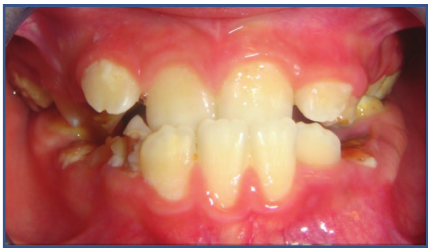
Figure 5: Abnormal overbite with overlap of the upper teeth.